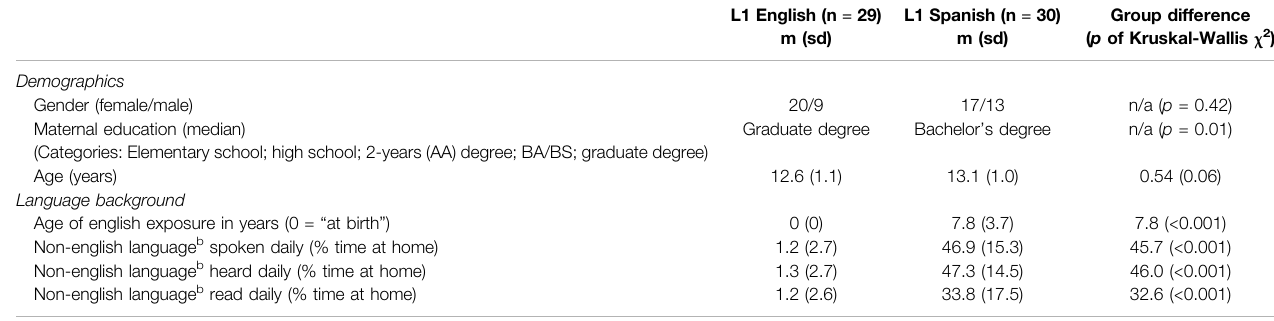
TABLE 1 | Participant demographic characteristics.